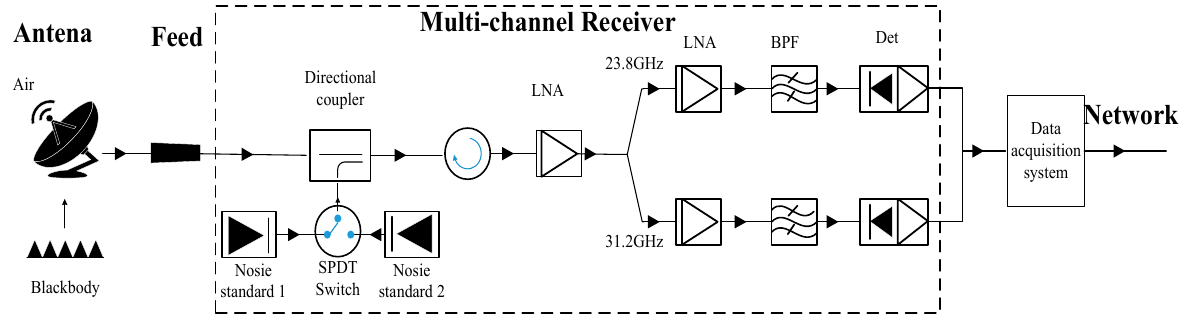
Figure 2. The schematic diagram of the HZD-X water vapor radiometer.